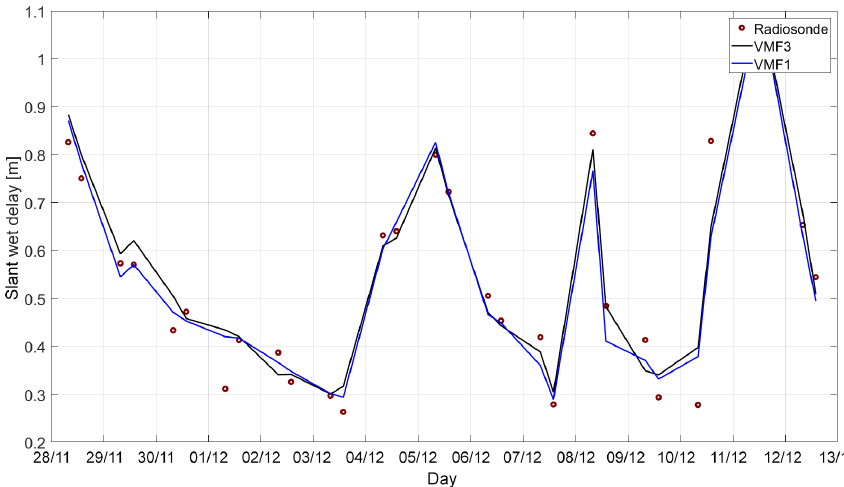
Figure 4. Comparison of slant wet delays (cid:49)L w at an elevation angle of 5 ◦ at Wettzell.